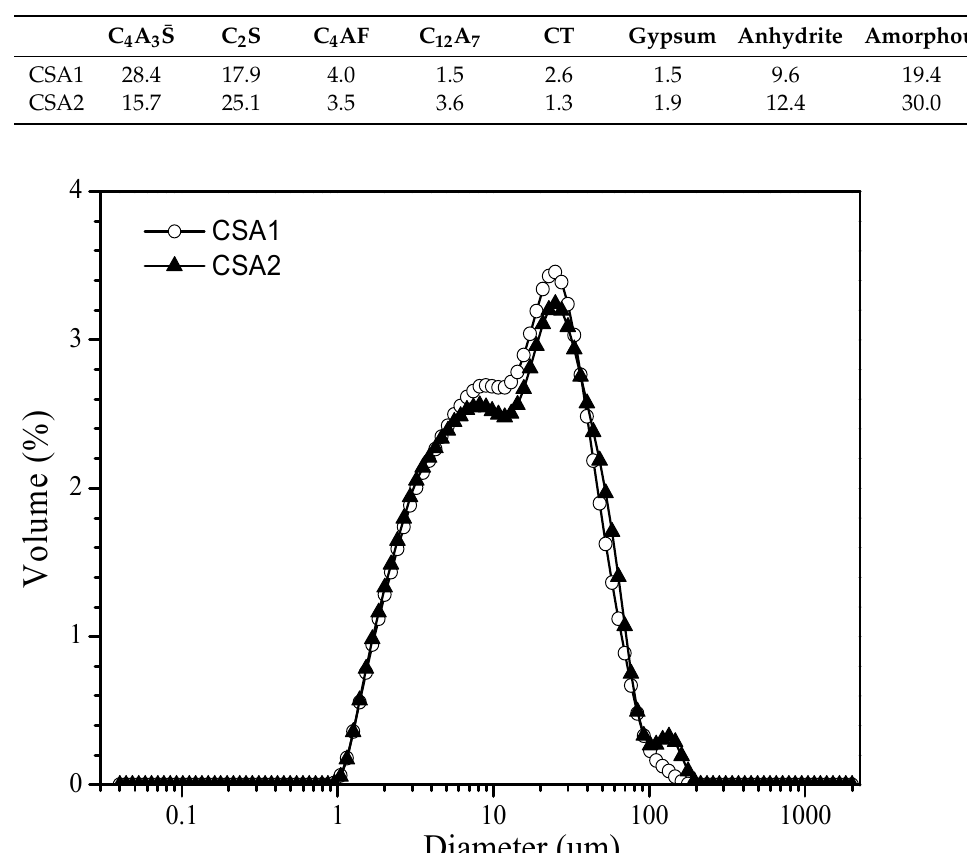
Table 2. Mineral composition of cements Wt/%.